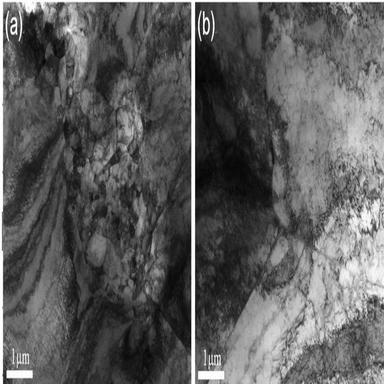
TEM micrographs at the surface (a) and at the core (b) of the 1440-600 sample after tensile strain of ~4%.